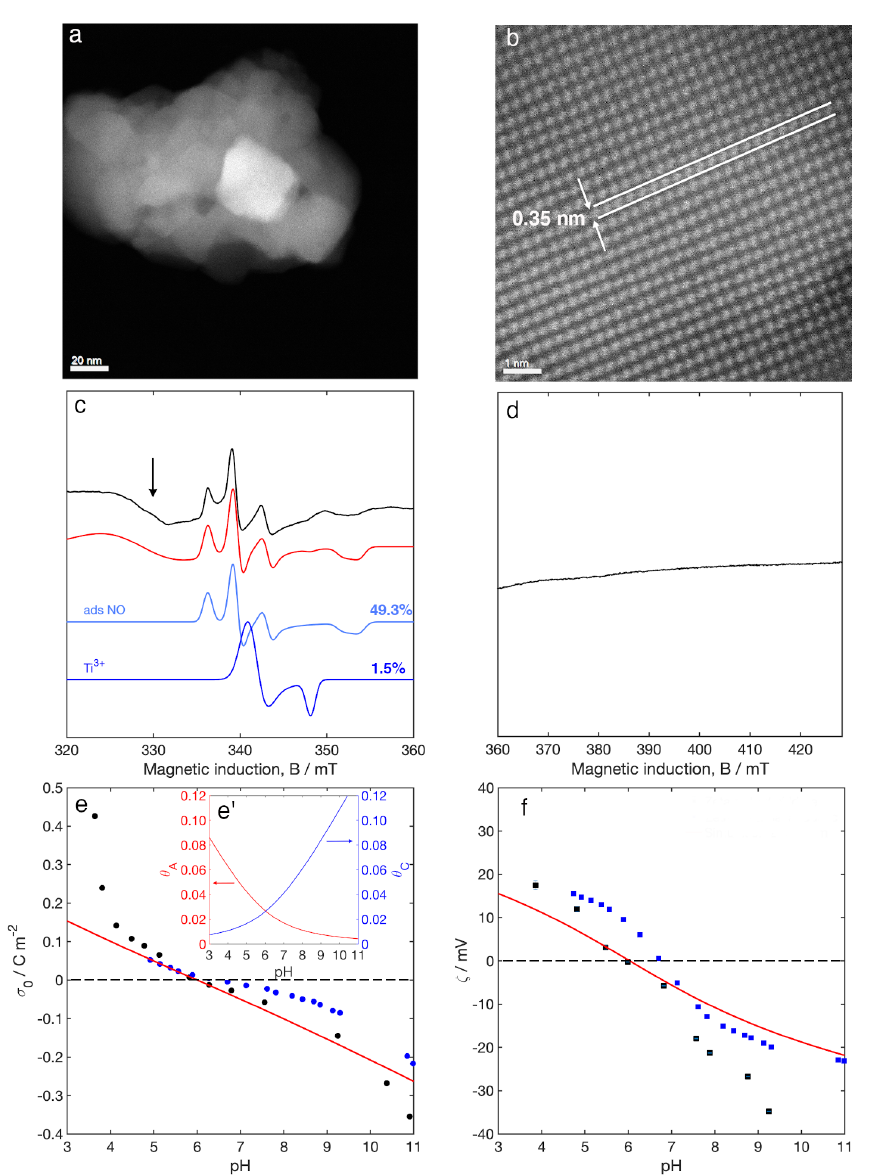
Figure 3. Undoped anatase TiO 2 : ( a , b ) Representative low and higher magnification HAADF-STEM images. ( c ) Experimental (black) and simulated (red) X-band CW EPR spectra recorded at 50 K around the free-spin region. The two major EPR signals identified are deconvoluted. The relative spectral contributions are 49.3% adsorbed NO and 1.5% Ti 3+ . The black arrow indicated the broad resonance at approximately g = 2.05 with spectral contribution equal to 49.2%. ( d ) Experimental X-band CW EPR spectra measured at 50 K at higher magnetic induction. The experimental spectra were recorded at 100kHz field modulation frequency, 0.2mT field modulation amplitude, 2µW microwave power and 72dB receiver gain. ( e ) Experimental (discrete points) and simulated (red solid line) surface charge density plot at constant ionic strength I = 10 − 2 molL − 1 . The black points are the experimental σ 0 obtained from the mass titrations in Figure S2, while the blue points are the experimental σ 0 obtained according to the electrolyte titration as in Folli et al. [40]. Inset ( e’ ) shows the simulated surface sites speciation relative to the surface site complexes with cations (Na + ) and anions (NO – 3 ). ( f ) Experimental (discrete points) and simulated (red solid line) electrokinetic ( ζ ) potential measured at constant ionic strength I = 10 − 2 molL − 1 . The black points represent ζ measured using the laser Doppler microelectrophoretic method, while the blue points are ζ measured using the acoustic